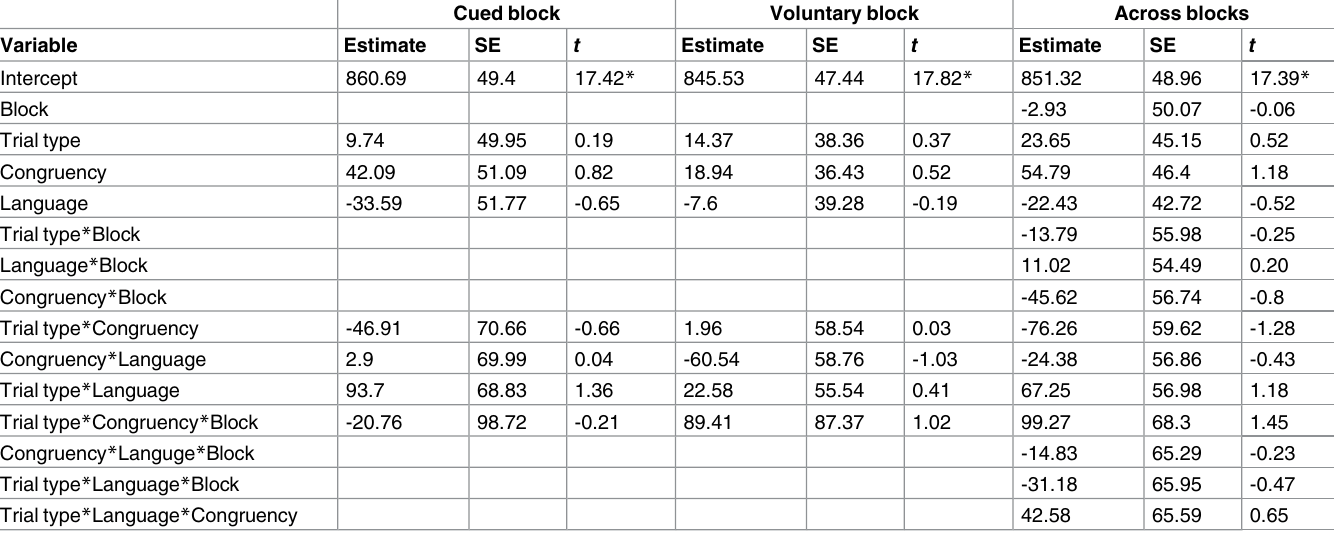
Table 6. Results on naming latency in cued and voluntary blocks (Experiment